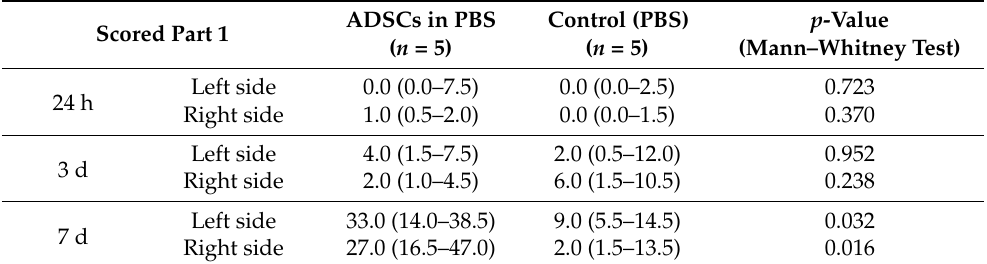
Table 2. Immunohistochemical analysis of olfactory marker protein (OMP) expression in the olfactory epithelium of mice 24 h, 3 d, and 7 d after left side nasal administration of ADSCs or PBS.